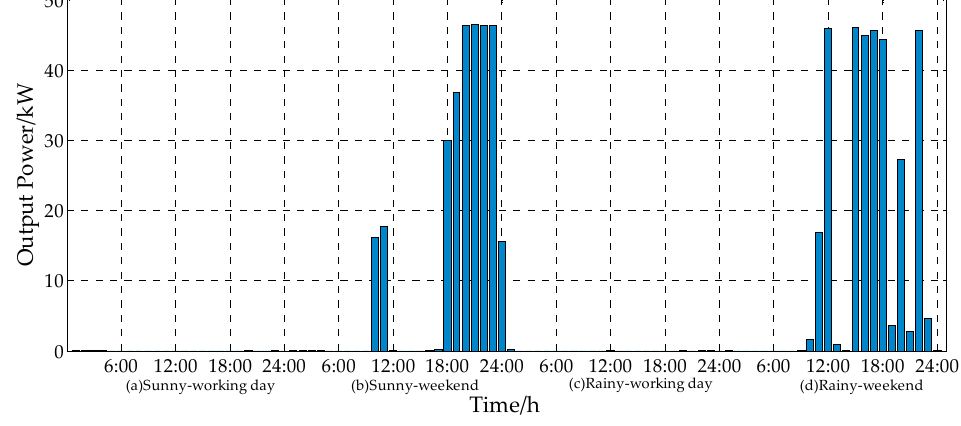
Figure 9. The LCQ dispatch optimization results for MG in each period for four scenarios.